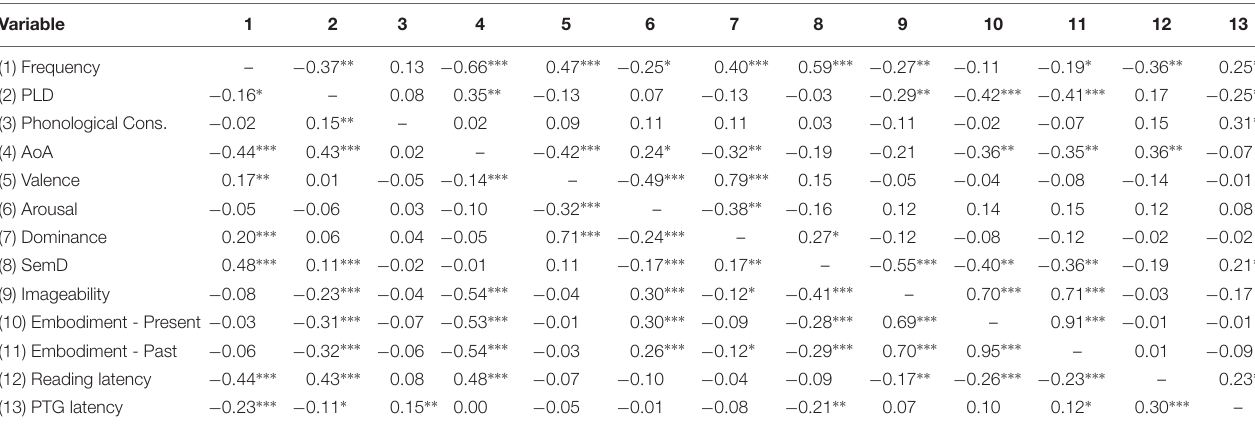
TABLE 6 | Correlations between predictor variables and dependent measures in Experiment 3a and 3b (Reading and Past Tense Generation). Variable 1